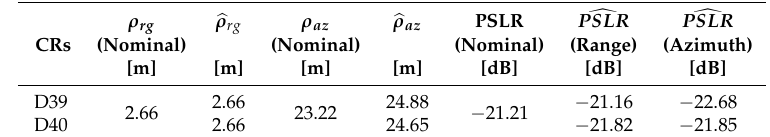
Table 5. Quality parameters for the corner reflectors focused through the ESA processor within burst 8 of sub-swath 1: the nominal and estimated spatial resolutions along range ( ρ rg and ˆ ρ rg , respectively), along azimuth ( ρ az and ˆ ρ az , respectively ), the nominal and estimated PLSR ( PSLR and (cid:92) PLSR , respectively) along range and azimuth are presented.